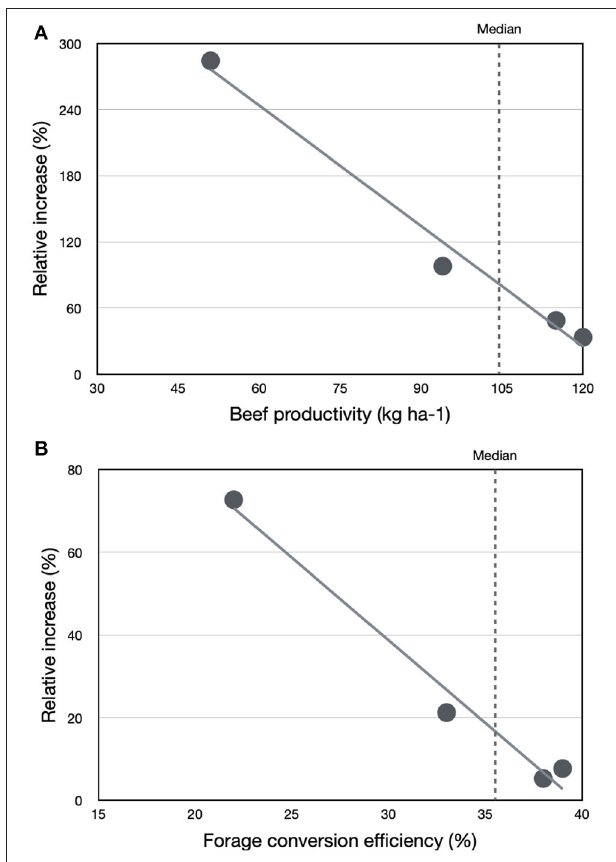
FIGURE 4 | Room for improvement in terms of beef productivity (A) and forage conversion efficiency (B) when farmers engaged in regional innovation platforms, based on a 1998-2010 study at municipal level in General Lamadrid County, Buenos Aires, Argentina ( Rio de la Plata Grassland Biome), using data from Pacín and Oesterheld (2015). Lamadrid County comprises 481,000 ha and had 437,000 heads of cattle at the time of this study, of which 37,000 were owned by farmers who participated in platforms. The four points shown in the figures correspond to years 2000/1, 2003/4, 2006/7, and 2009/10. Y-axis depicts the relative difference (%) between farms with and without technical